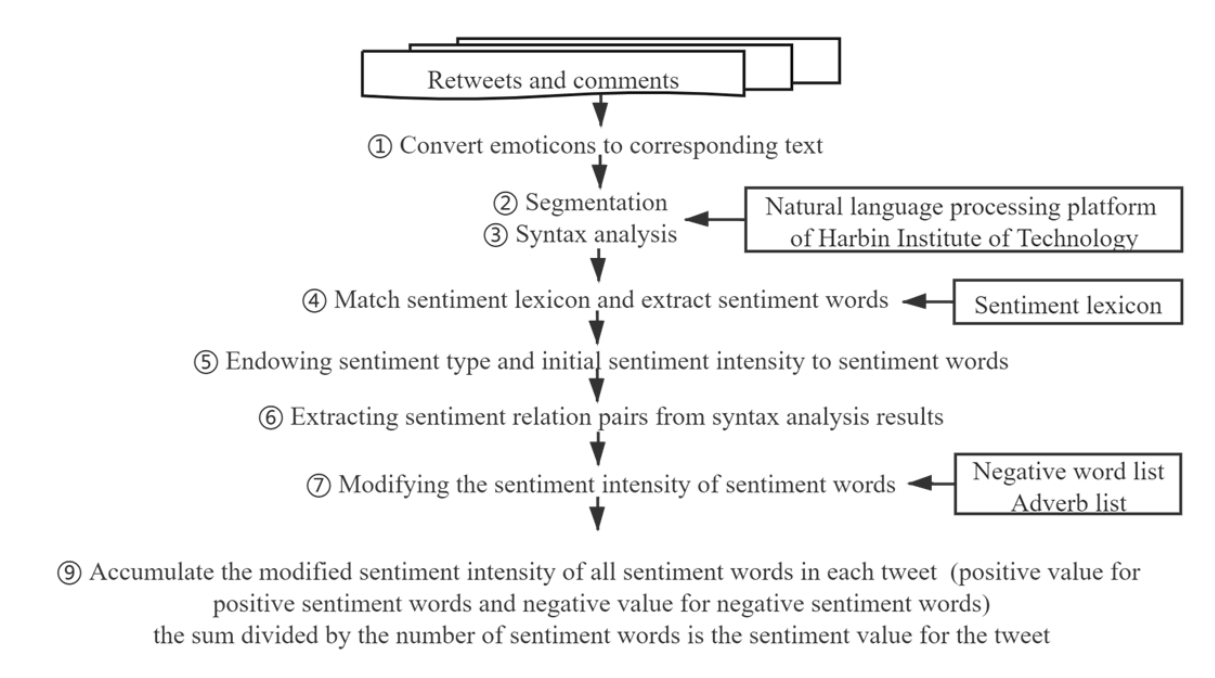
Figure 2. Sentiment